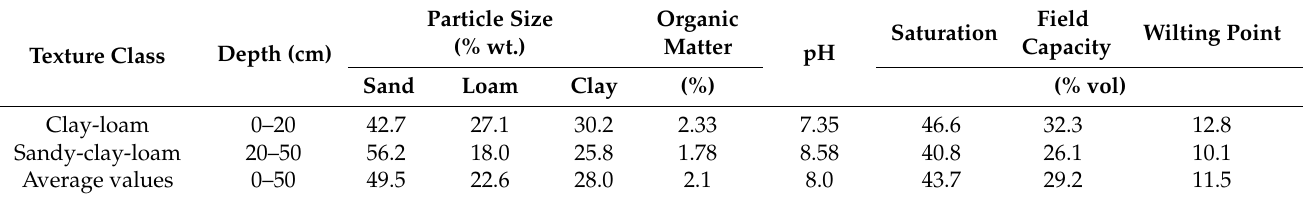
Table A1. Selected soil textural and hydraulic properties.